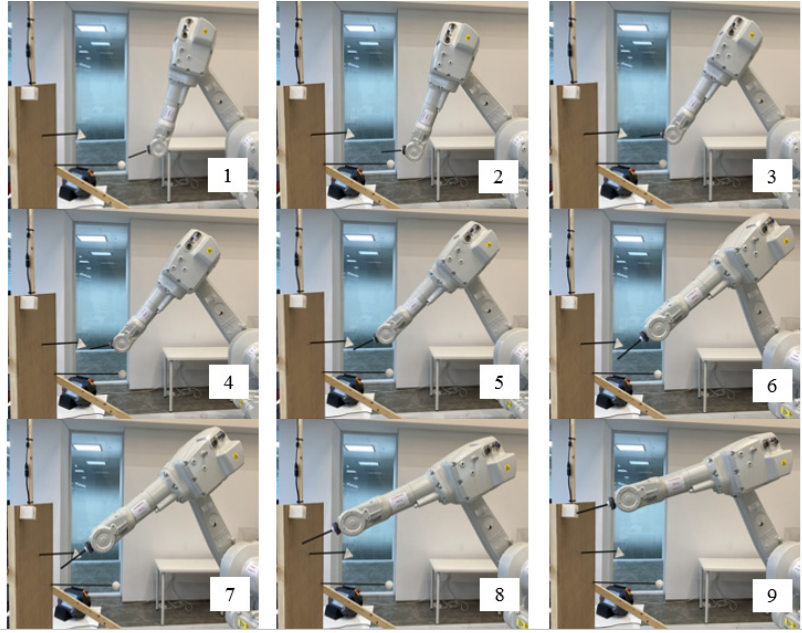
13 of 18 Figure 8. Experimental setup: cameras, robot arm, workspace, sphere (start), pyramid (obstacle), cube (target).